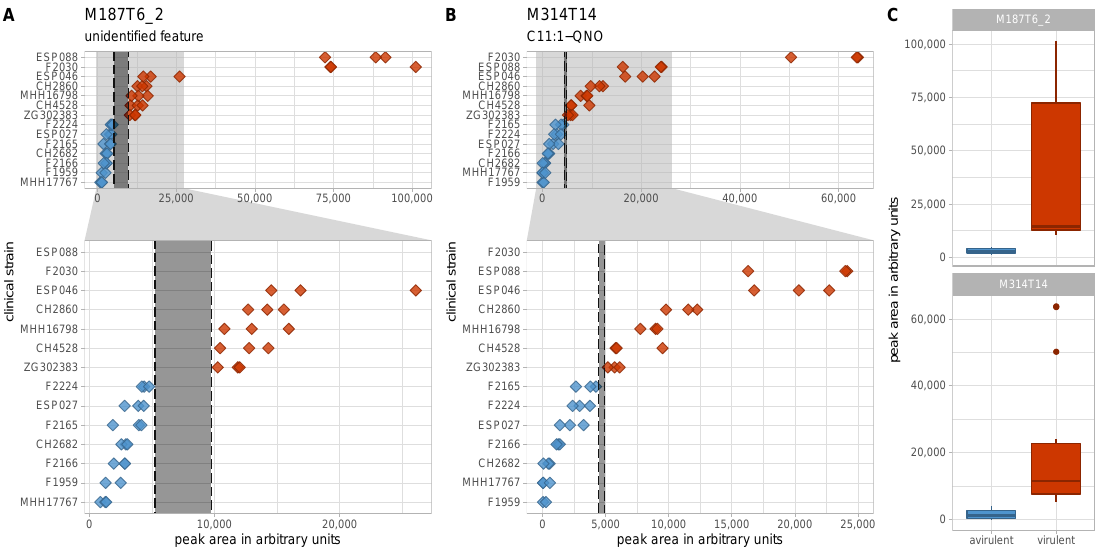
Figure 5. Levels of the two non-overlapping features in the discovery data set. ( A , B ) Peak area in arbitrary units is plotted on the x-axis for the two perfectly separating features M187T6_2 ( A ) and M314T14 ( B ). Full range of the x-axis is shown in the top panels and an enlarged region of the lower x-axis range is depicted in the lower panels. Non-overlapping spaces are marked by dashed lines and grey shading. The difference between the lowest level in the virulent cluster A group und the highest level in the avirulent cluster B group is a lot more pronounced for M187T6_2. ( C ) Peak area in arbitrary units is plotted on the y-axis for the two perfectly separating features M187T6_2 and M314T14 as box plots to visualize data distribution. Red—virulent cluster A strains, blue—avirulent cluster B